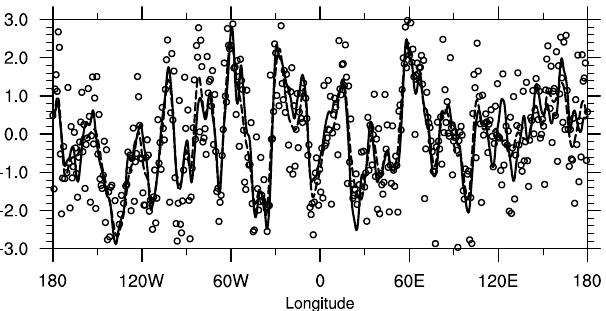
Fig. 1. True signal x t (solid black line), observations y o (circles) and the analysis x a (dashed black line) simulated with the pre- scribed statistics for background and observation errors (see text).